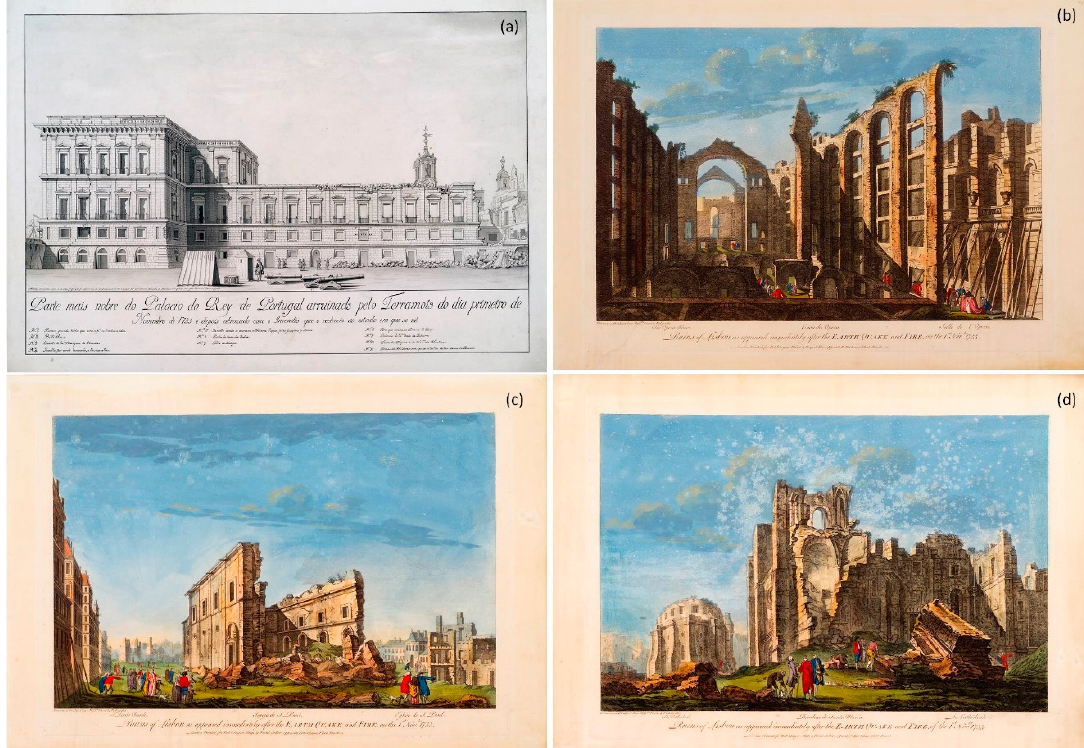
Figure 14. Iconography of the 1755 disaster at the study area: ( a ) copy of the drawing of the noblest part of the Royal Palace (#A) [41]; ( b ) painting of the Opera House (#N) [42]; ( c ) painting of the São Paulo church (#1) [43]; ( d ) painting of the Sé (#9) [44].